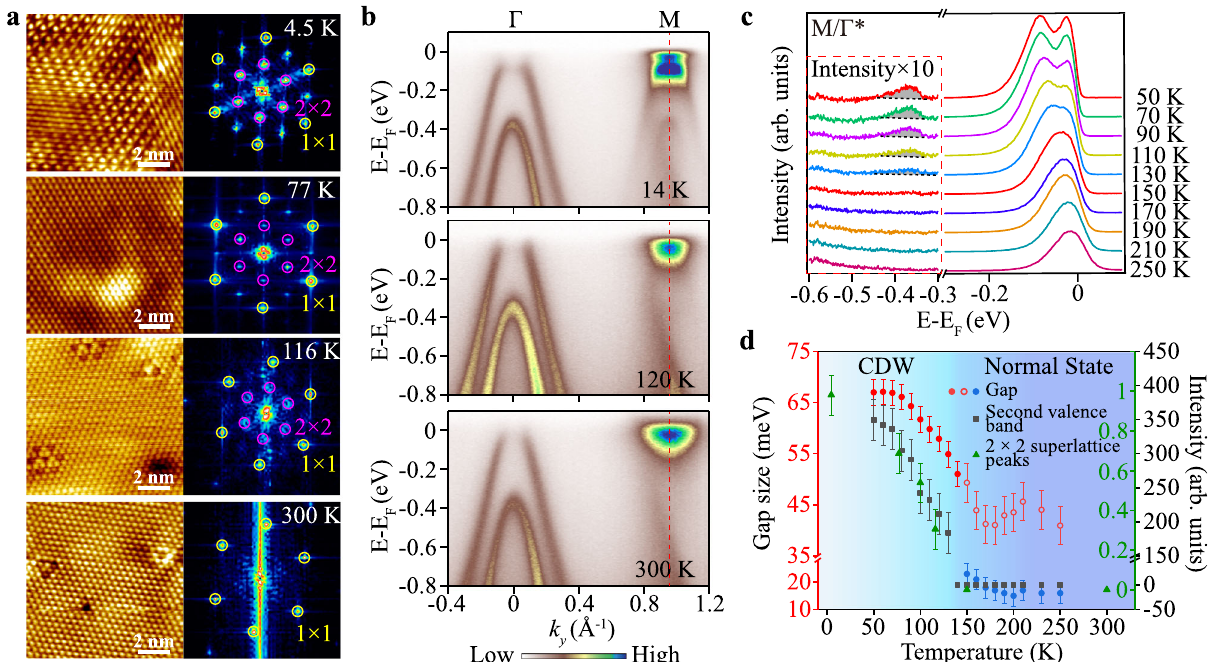
Fig. 2 | Temperature dependence of CDW state in monolayer 1T-ZrTe 2 . a Atomically resolved STM images of 10nm×10nm and corresponding FFT images at 4.5K [ V bias = − 50mV, I =200pA], 77K [ V bias =50mV, I =250 pA], 116K [ V bias = − 150mV, I =280 pA] and 300K [ V bias = − 100mV, I =300 pA]. b The band structures measured along the experimental Γ -M direction at 14, 120, and 300K. c EDCsmeasuredexactlyatM/ Γ *(correspondtoreddashedlinesin( b ),asafunction of temperature. Three peaks are clearly recognized in the spectra measured at